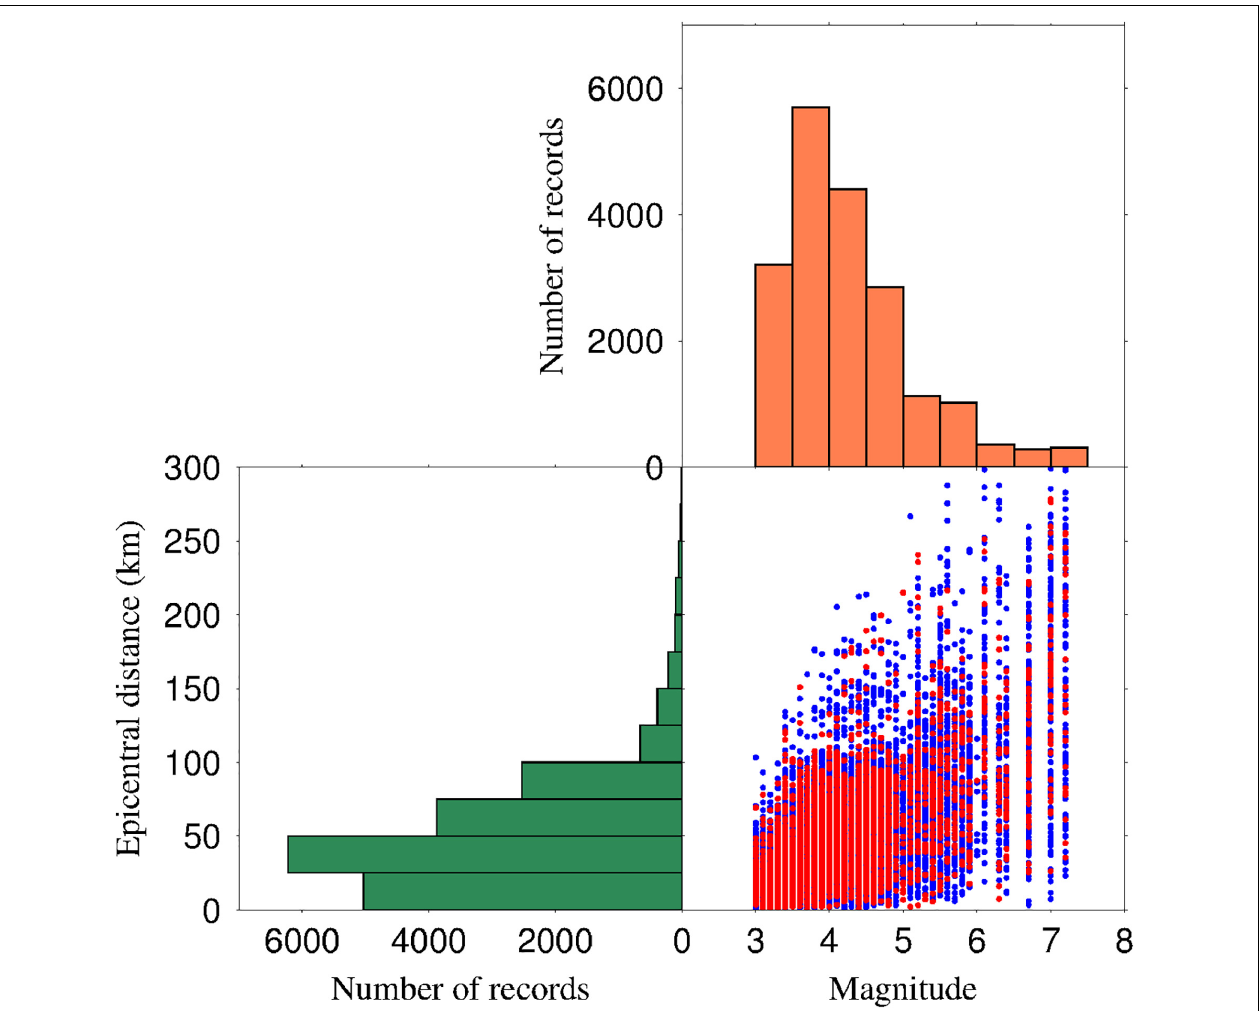
FIGURE 2 | The distribution of the epicentral distance and magnitude records. A histogram for the number of selected seismic records with the magnitude is shown at the top. An interval of 0.5 is used for each magnitude bin. A histogram of the number of selected seismic records with the epicentral distance is shown at the bottom left. An interval of 25 km is used for each epicentral distance bin. The distribution between the magnitude and epicentral distance is shown at the bottom right. Solid blue circles indicate the training dataset used to train the DCNN-M model. Solid red circles indicate the test dataset used to test the DCNN-M model